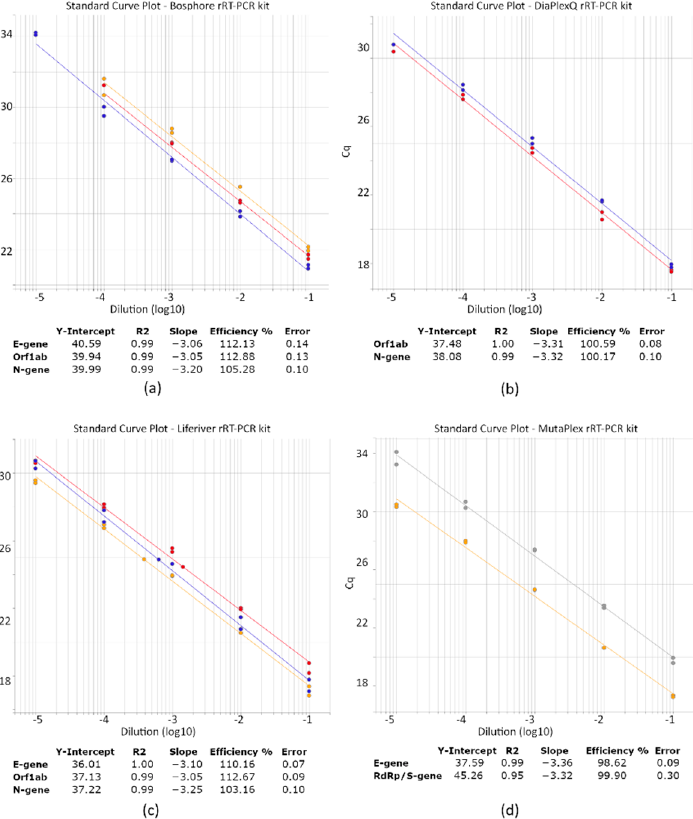
Figure 2. PCR efficiency of the studied RT-qPCR kits detecting SARS-CoV-2. PCR efficiency was analyzed using a duplicate 10-fold dilution series of the standardized clinical sample containing SARS-CoV-2 viral RNA. Linear regression for each target gene: E-gene (yellow line), N-gene (blue line), Orf1ab (red line), and RdRp (grey line) was performed in Quant Studio 6 Pro to obtain the slope and R2. Panel ( a ) refers to the efficiency of the Bosphore, ( b ) DiaPlexQ, ( c ) Liferiver, and ( d ) MutaPlex kit.